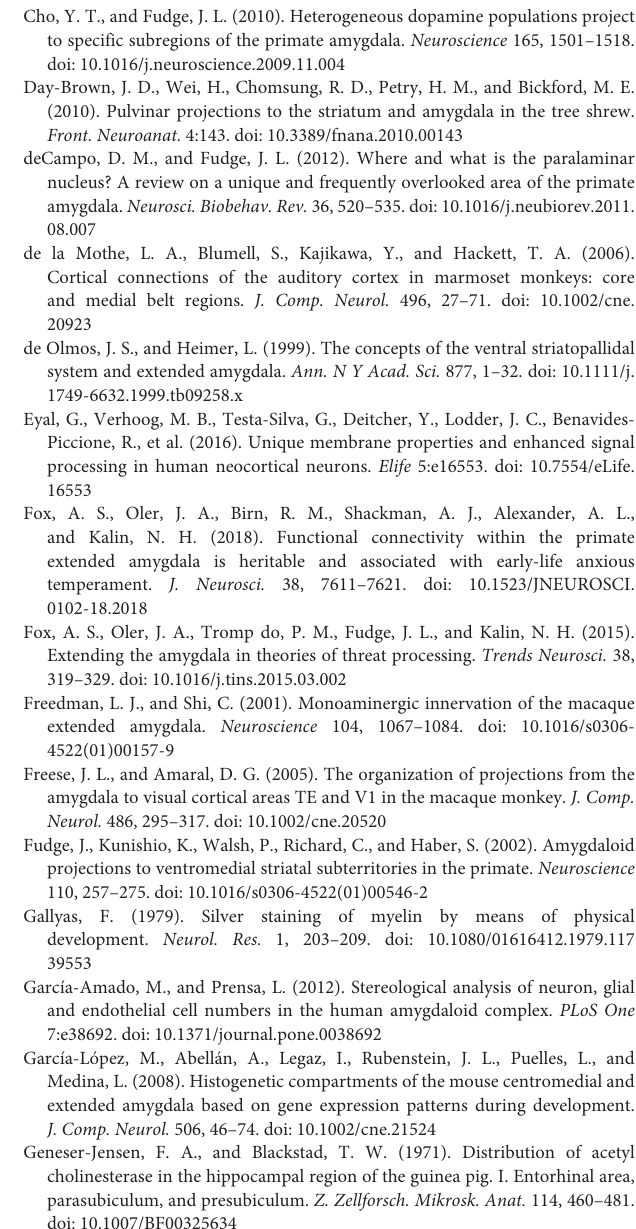
FIGURE S1 | High-power photomicrographs showing the cytoarchitecture of the Bmd and adjacent areas. The Bmd is distinguished by its fewer Nissl-stained neurons compared to the Bmag; also the density of neurons seems to be slightly lower in the Bmd. It is separated from the Ast by one of the I. Note also differences among the cytoarchitecture of the three Ce subdivisions, showing that the CeL has a lower density of cells than the CeM and the CeC. Scale bar: 250 µ